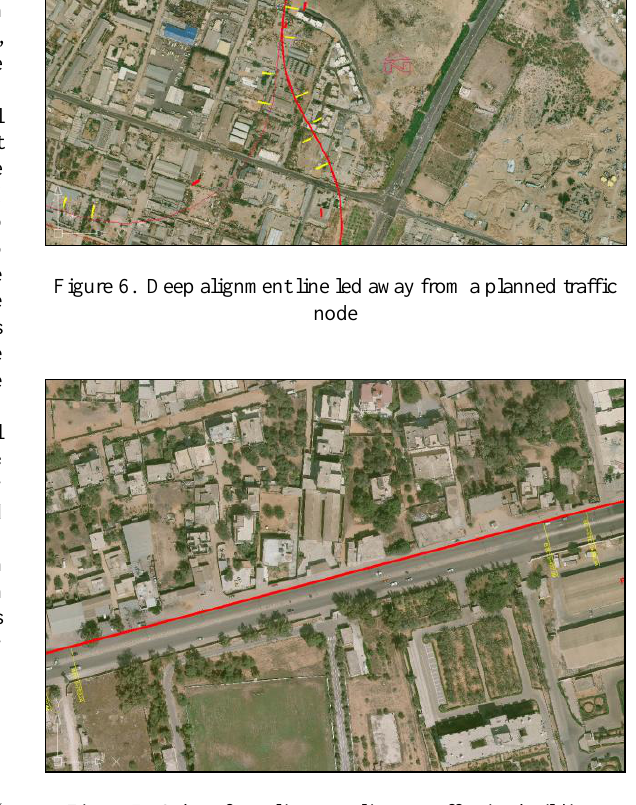
Figure 7. Subsurface alignment line not affecting